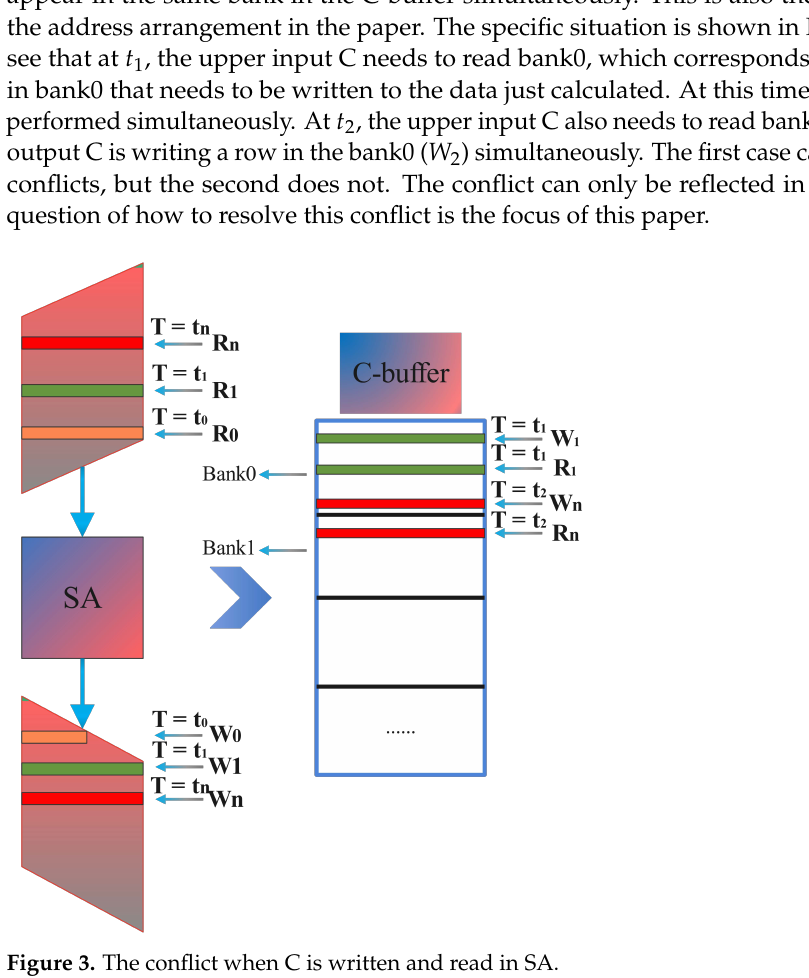
Figure 3. The conflict when C is written and read in